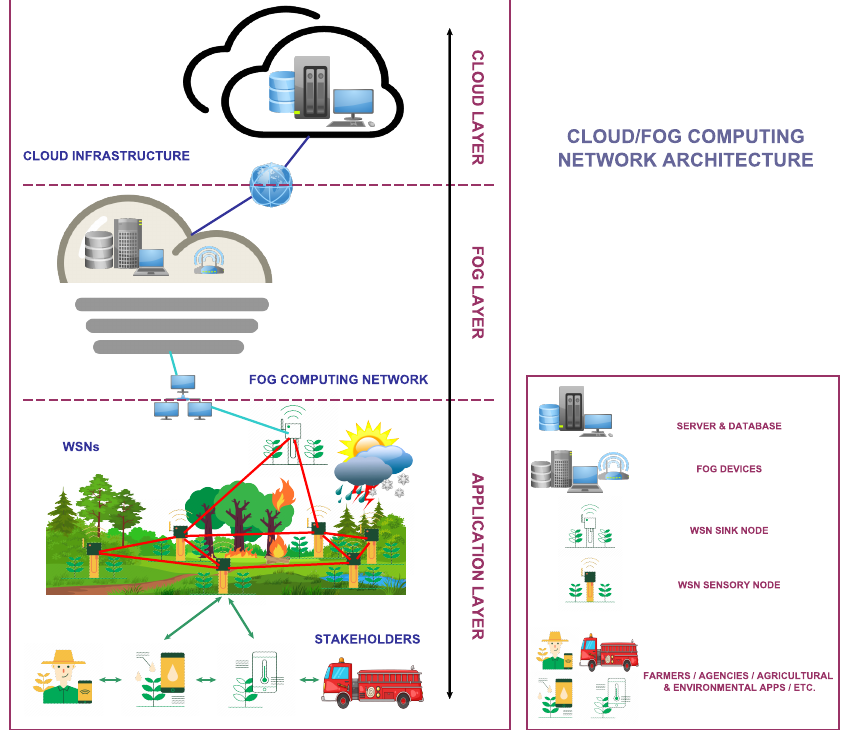
Figure 1. The considered three-layered cloud/fog computing IoT architecture for environmental monitoring, with an emphasis on fire detection